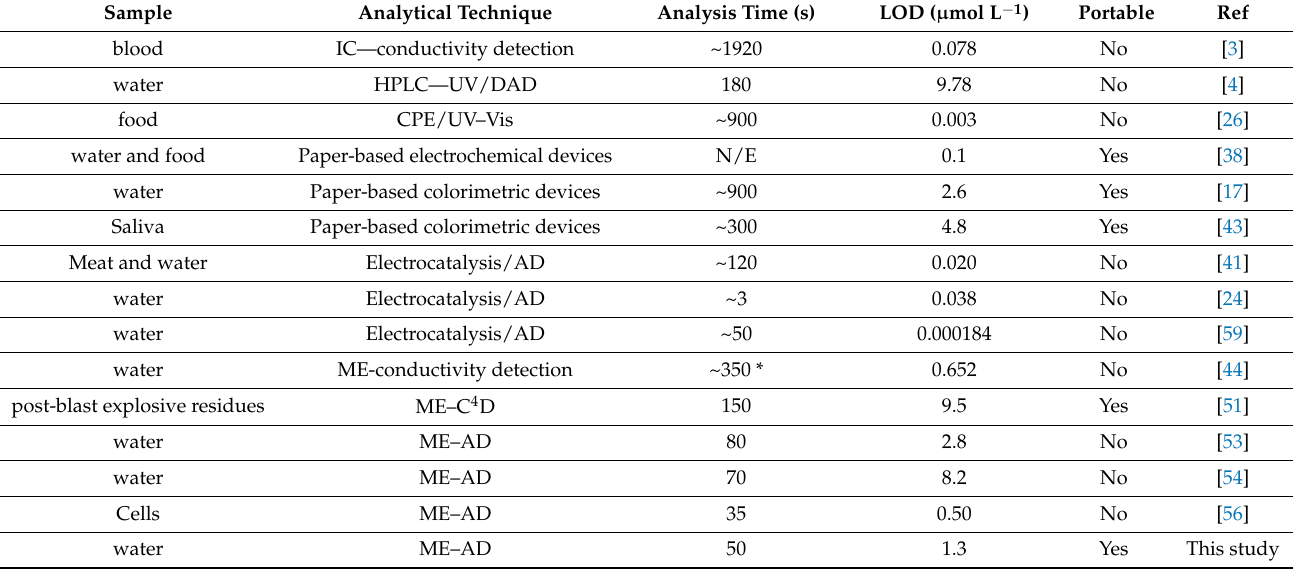
Table 2. Comparison of the analytical performance of the proposed methodology for nitrite determi- nation with other studies reported since